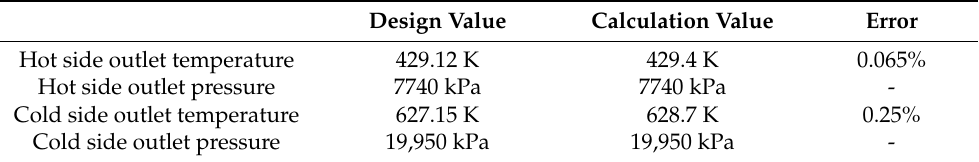
Table 2. The outlet temperature of PCHE.